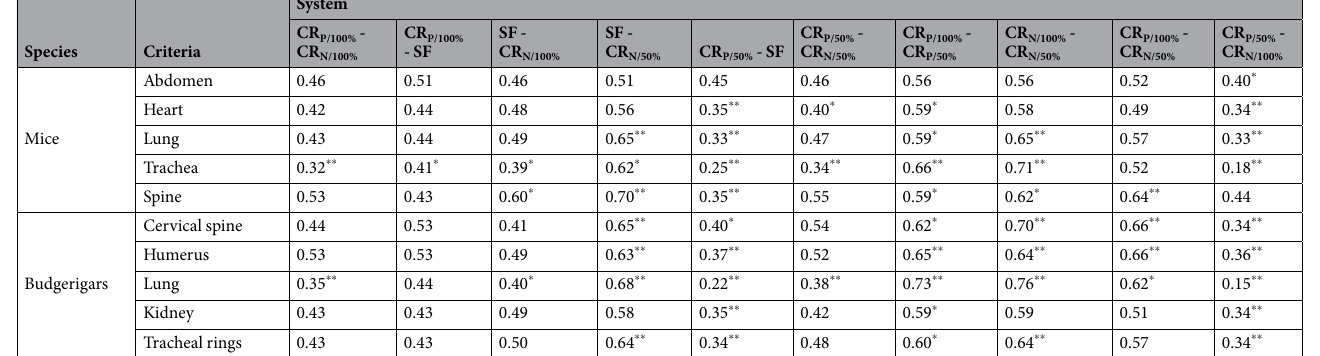
Table 5. Summary of the statistical analyses stating significant occurrences in intersystem variability through statistically calculated AUC values. * Significant (p ≤ 0.05), ** highly significant (p ≤ 0.001). Interpretation: an equal assessment of the criterion would result in a value of 0.5. The more one system is superior, the more the value tends to 1.0 (first system) or 0.0 (second system). “CR N ” refers to AGFA DX-S (Agfa